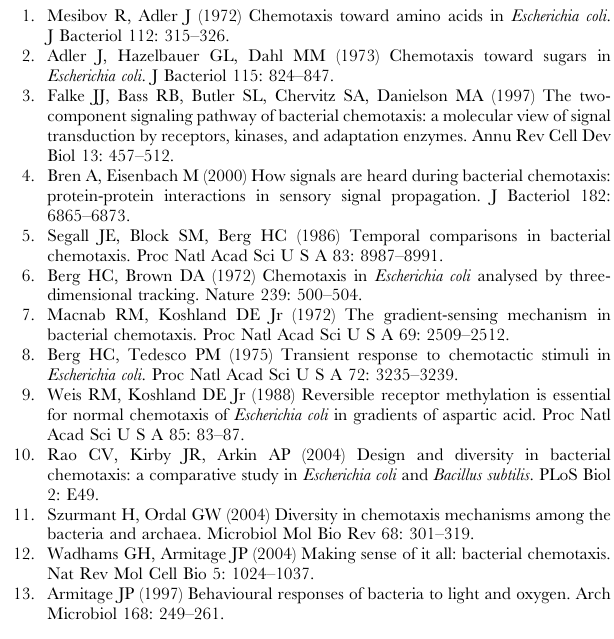
Figure 2: The matrix from run 03 for 4-protein pathways, fixed attractant conditions. Figure 3 top row: Matrices from runs 02, 03, and 04 for 4-protein pathways, fluctuating attractant conditions. Figure 3 bottom row: Matrices from runs 02, 03, and 04 for 4-protein pathways, non- periodic boundary conditions.